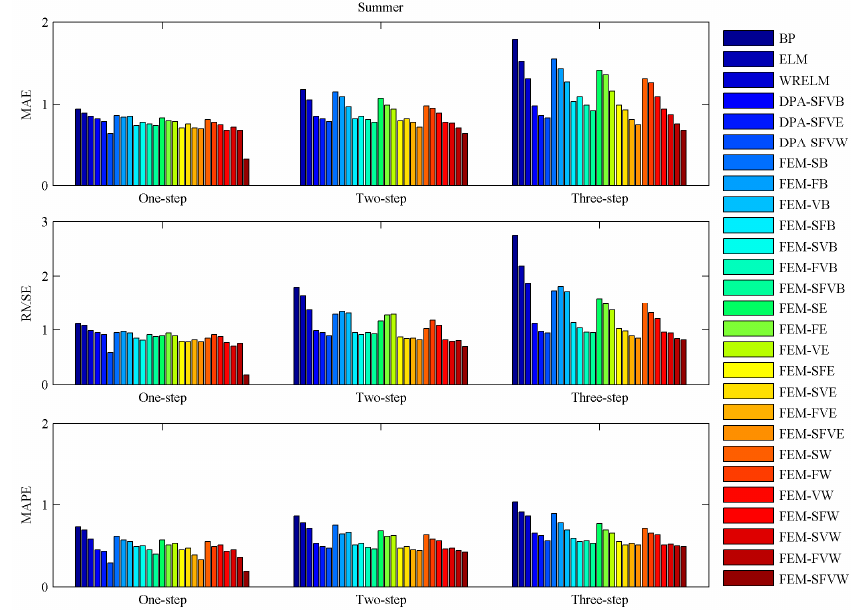
Figure 12. Performance comparison of different models in terms of MAE, RMSE and MAPE in summer.